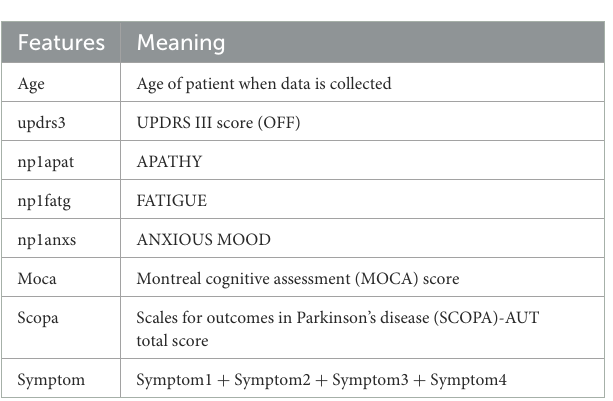
TABLE 1 List of selected